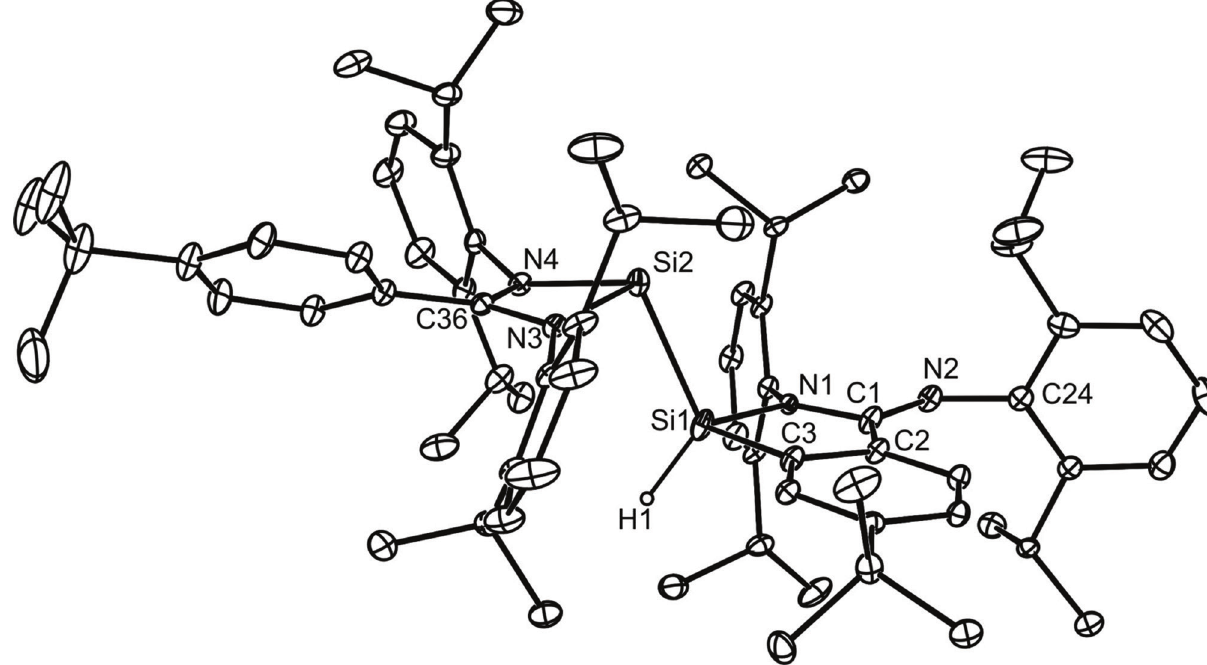
Figure 2: Thermal ellipsoid plot (25% probability surface) of the molecular structure of 3 (hydrogen atoms, except the hydride, omitted). Selected bond lengths (Å) and angles (°): Si(1)-N(1) 1.849(10), Si(1)-C(3) 1.875(2), Si(1)-Si(2) 2.394(1), Si(1)-H(1) 1.43(2), N(1)-C(1) 1.335(11), C(1)-N(2) 1.275(3), C(1)-C(2) 1.494(3), Si(2)-N(3) 1.8662(18), Si(2)-N(4) 1.8836(16), C(2)-C(3) 1.404(3), N(1)- Si(1)-C(3) 89.8(3), Si(2)-Si(1)-H(1) 121.1(9), N(3)-Si(2)-N(4) 69.39(7), N(3)-Si(2)-Si(1) 96.97(6), N(4)-Si(2)-Si(1) 106.08(6), C(1)-N(2)-C(24)